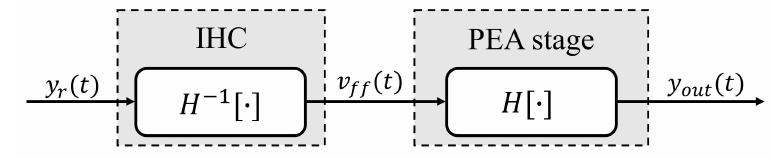
Figure 4. Block diagram of the open-loop controller based on the